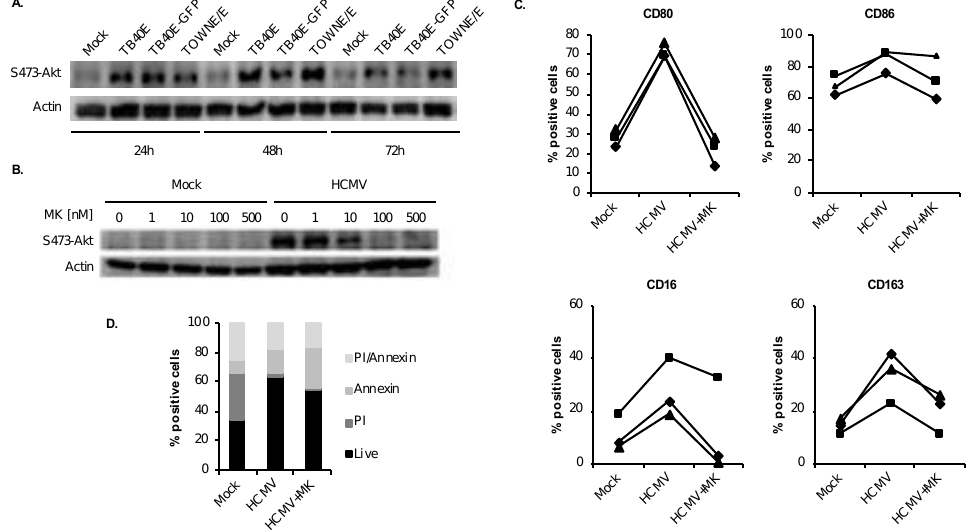
Figure 2. HCMV uses Akt to mediate monocyte-to-macrophage di ff erentiation. ( A ) Human peripheral blood monocytes were mock- or HCMV-infected with TB40E, TB40E-GFP, or TOWNE / E for 24, 48, or 72 h. Levels of p-Akt (S473) and actin (loading control) were detected by immunoblotting from whole cell lysates. ( B ) Monocytes were pretreated for 1 h with an Akt inhibitor, MK-2206 2HCL (MK), at 1, 10, 100, or 500 nM, or vehicle control. Cells were then mock- or HCMV-infected for 24 h and levels of p-Akt and actin detected by immunoblotting from whole cell lysates. ( C ) Monocytes were pretreated for 1 h with 5 µ M of MK, or vehicle control, then mock- or HCMV-infected with TB40E for 48 h. The percent of positive cells for M1 (CD80 and CD86) and M2 macrophage markers (CD16 and CD163) were measured by flow cytometry. ( D ) Monocytes were pretreated for 1 h with 5 µ M of MK or vehicle control, then mock- or HCMV-infected for 48 h. Viability was measured through propidium iodide (PI) and annexin V staining by flow cytometry. Live cells (double negative for PI and annexin V) are represented by black bars. ( A – D ) Results are representative of 3–6 independent experiments using monocytes from di ff erent donors.